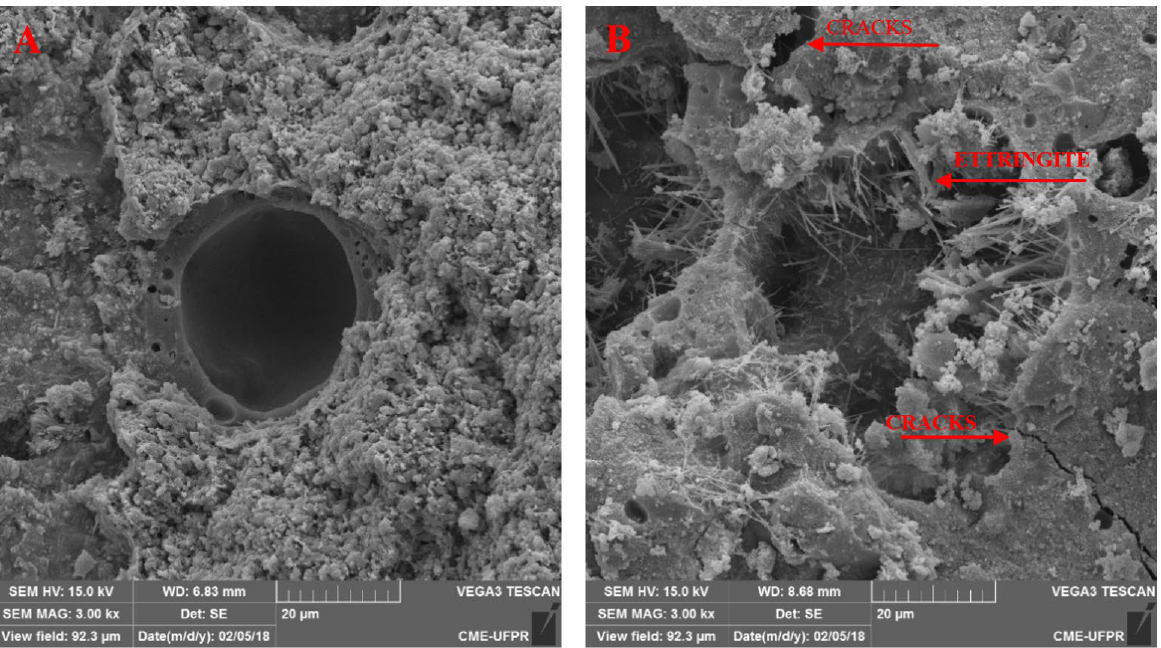
Figure 7. Images obtained at 720 days from reference and 5.0% SO 3 series. A – Reference series with pore free of products and without cracks. B – 5.0% SO 3 series with ettringite and